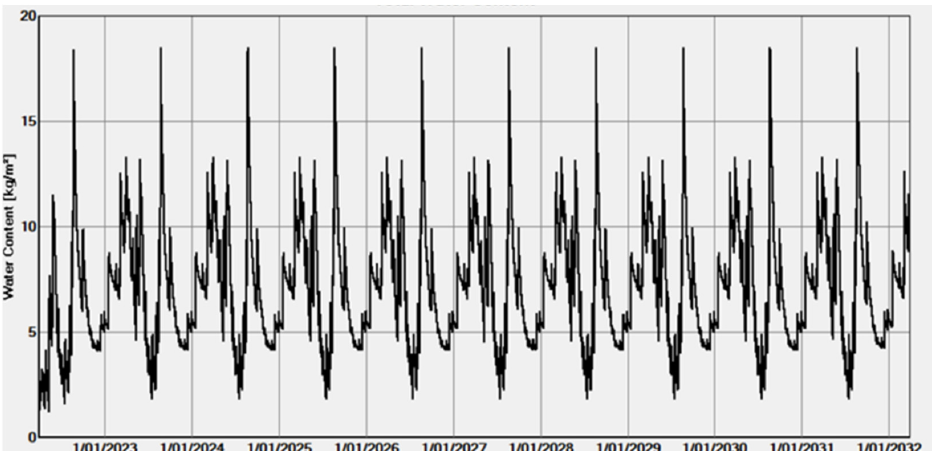
Figure 14. Graph of typical 10-year fluctuation of moisture content for the wall assembly in west orientation for pliable membrane B (single and multipoint).